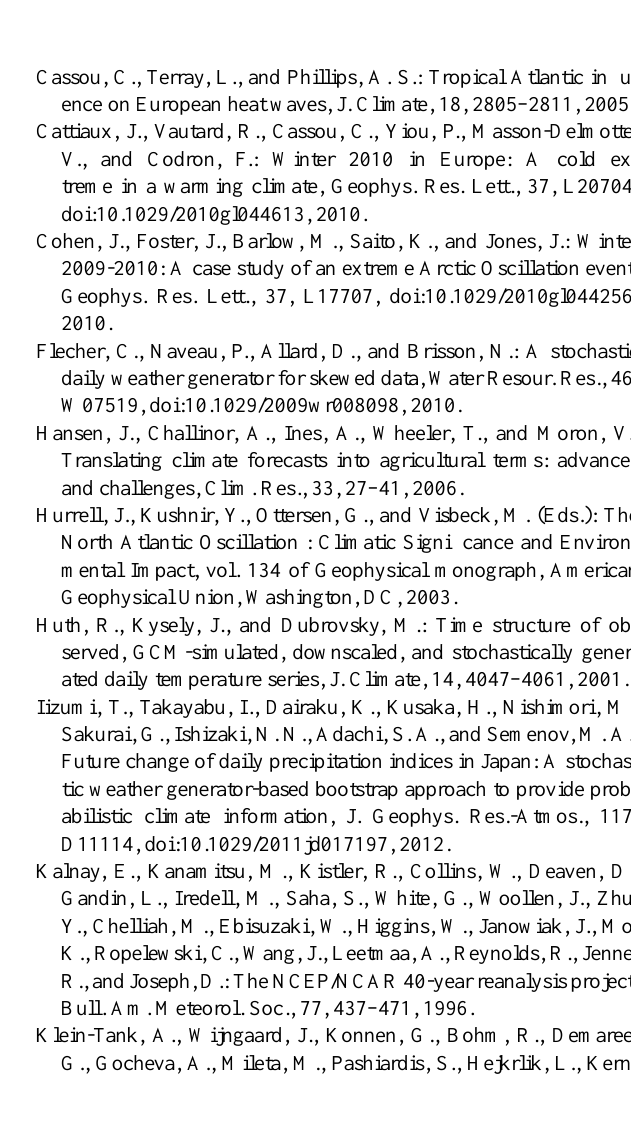
Fig. 10. Left panel: Observed mean winter (December to February: DJF) temperature anomaly (in ◦ C) in Europe for the 6 coldest winters (lower 10th quantile of mean DJF temperature). Right panel: Probability of being below the 10th quantile of mean DJF temperature in 100 simulations of the “dynamic” weather